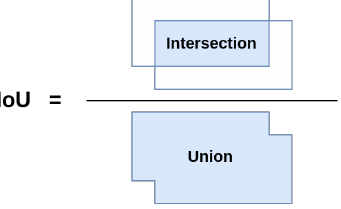
Figure 6. IoU calculation method, blue represents the area to be